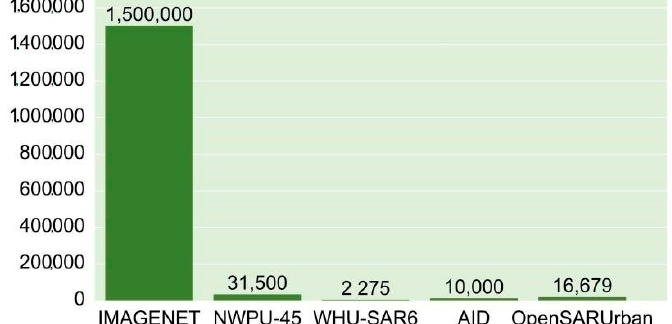
Figure A1. The total images number of RSSC datasets, i.e., OpenSARUrban [14], WHU-SAR6 [11],